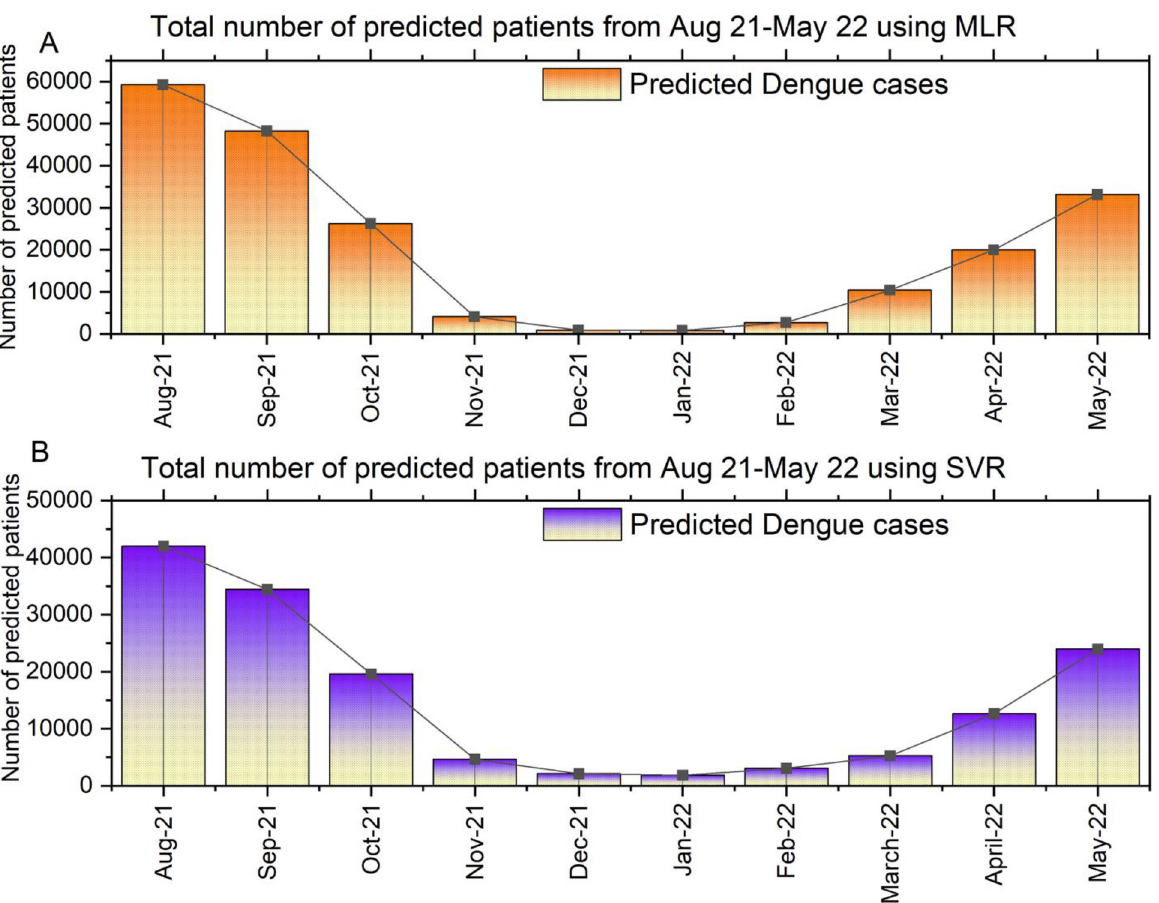
Fig 7. Month-wise dengue patients prediction trend using Multiple Linear Regression (MLR) and Support Vector Regression (SVR).